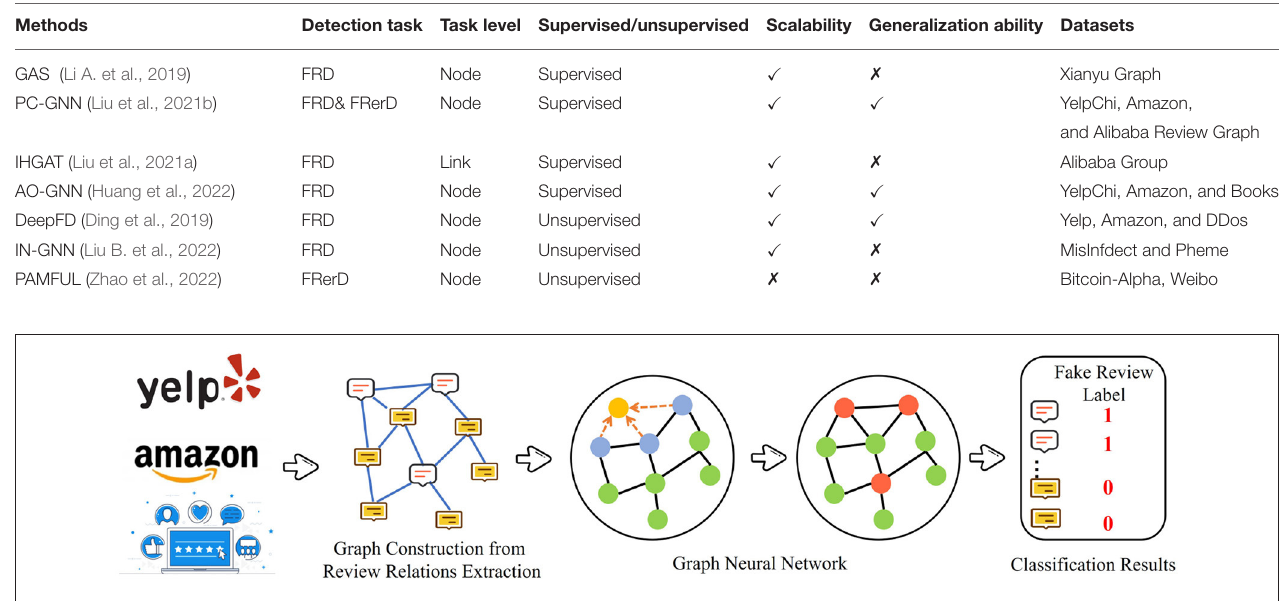
FIGURE 3 | Supervised methods with Graph Neural Network for fake review